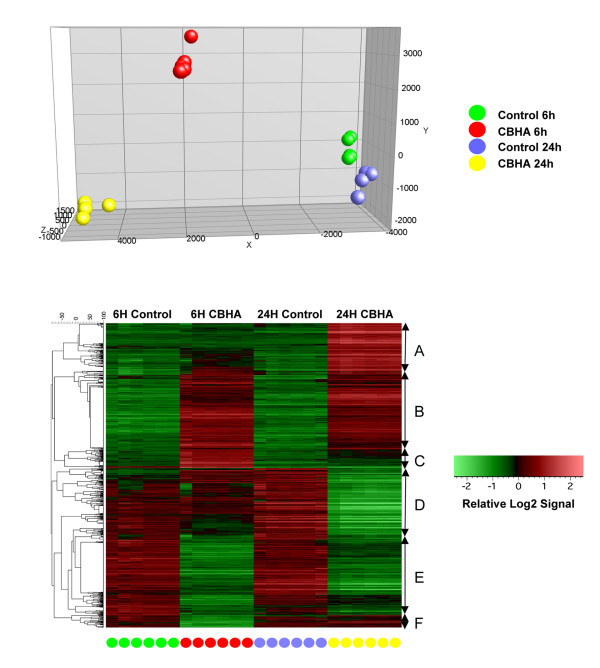
PCA and clustered heat maps of DEGs in the H9c2 cells treated with CBHA for 6 and 24 h. PCA of DEGs from six independent H9c2 cell samples representing CBHA treatment for 6 or 24 h shows unique locations of each treatment cohort (top panel). The heat maps of DEGs clustered using the statistical criteria described above and in Materials and Methods are shown (bottom).